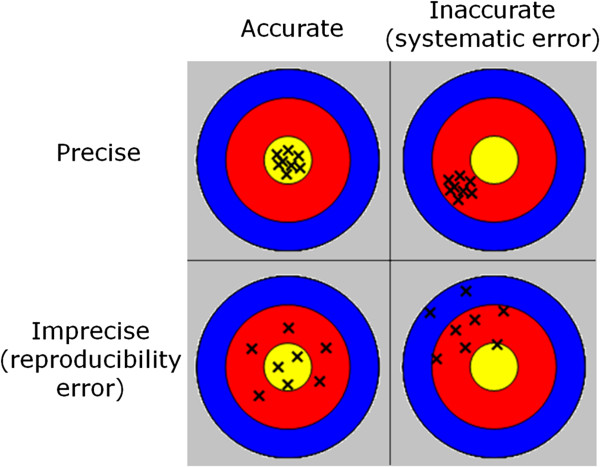
Illustration of accuracy versus precision. Accuracy refers to systematic errors, which create a bias, whereas, precision relates to the random component due to noise (http://www.jcmr-online.com/content/15/1/56/figure/F1).